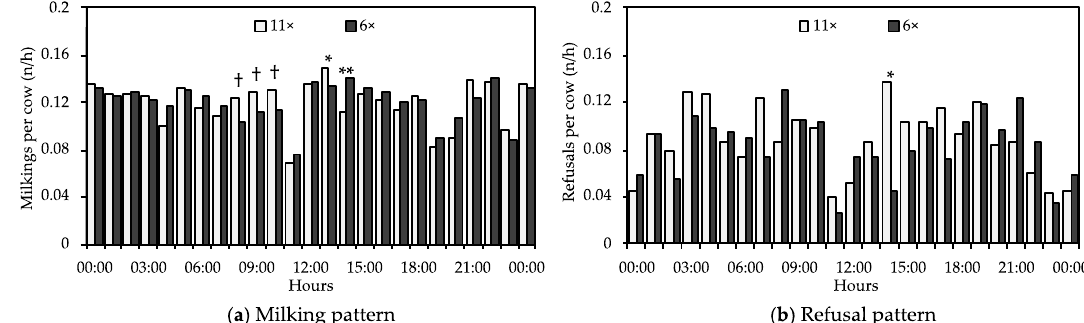
Figure 5. Average hourly ( a ) number of milkings and ( b ) automatic milking system (AMS) refusals per cow for different feed delivery frequencies (11 × and 6 × ). Data are the average of the two periods for each feed delivery frequency. Statistical differences between feed delivery are indicated with **( p < 0.01) and * p < 0.05). A tendency is indicated with † ( p < 0.10).